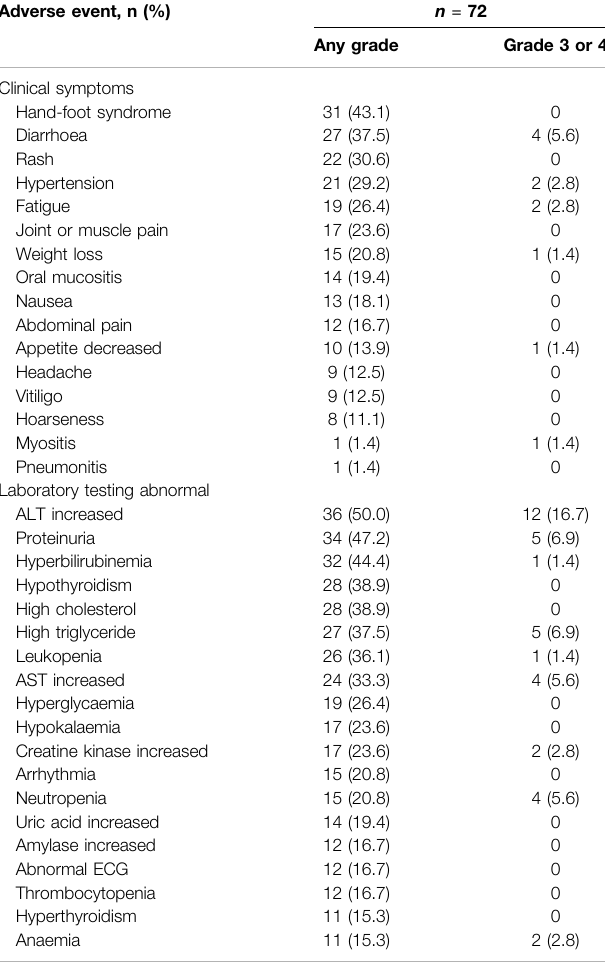
TABLE 3 | Common adverse events ( > 15%) and some TRAEs of special interest patients. Adverse event, n (%)